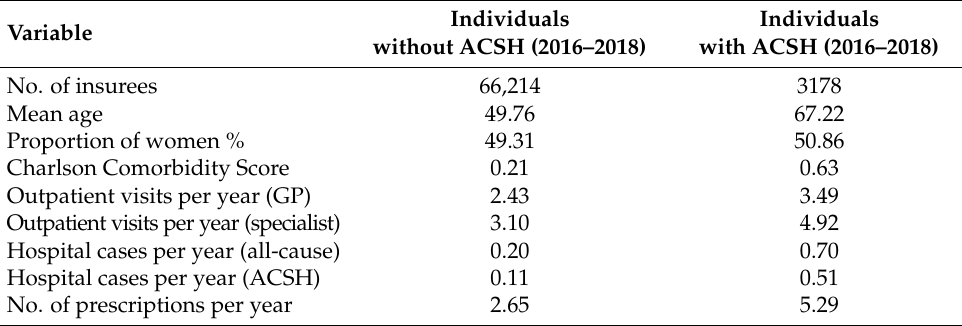
Table 1. Descriptive analytics of the ACSH cohort in